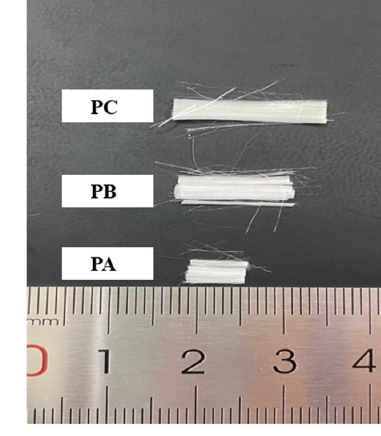
Figure 1. Fiber appearance characteristics.